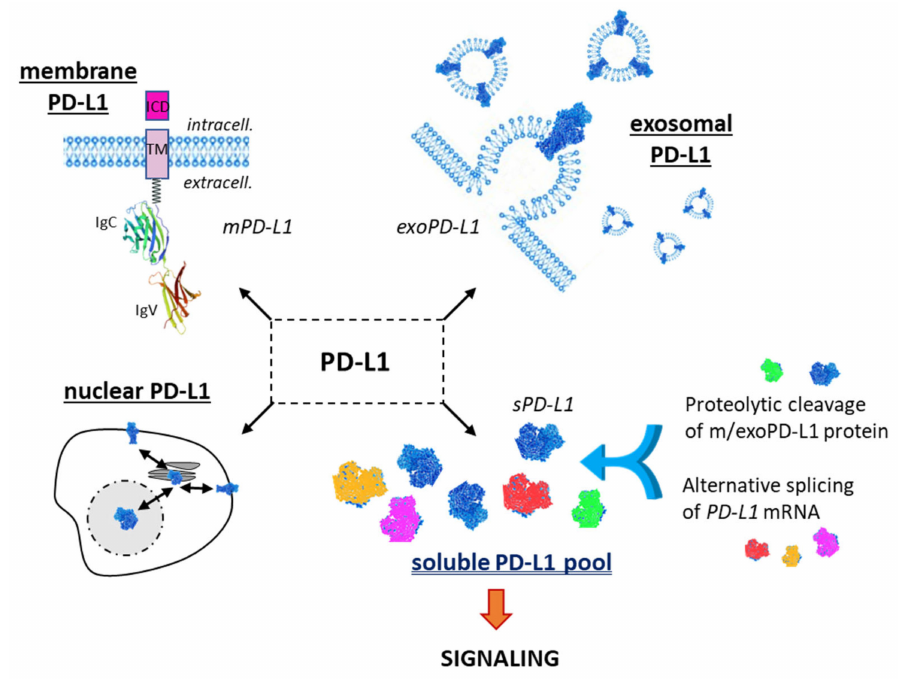
Figure 1. The different forms of the checkpoint protein PD-L1: membrane form (mPD-L1) with its characteristic transmembrane domain (TM) and intracellular domain (ICD); the exosomal form (exoPD-L1) embarked into extracellular vesicles released by a variety of cells; the nuclear form (nPD- L1) involved in the regulation of mRNA stability; the soluble forms (sPD-L1), which can derive either from proteolytic cleavage of m/exoPD-L1 or from an alternative mRNA splicing. m/exo/sPD-L1 can modulate T-lymphocyte activity via the PD-1 signaling